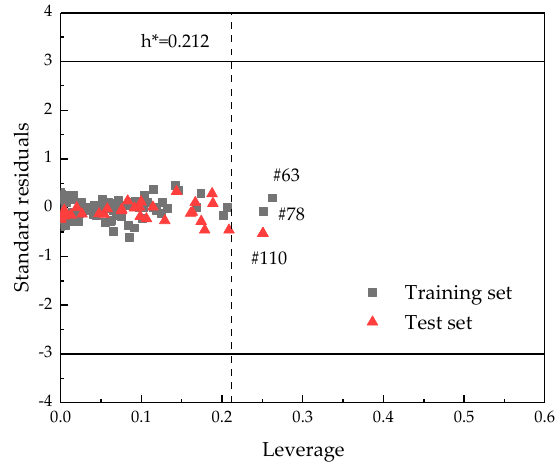
Figure 5. A Williams plot describing the applicability domain of the Quantitative Structure-Property Relationship (QSPR) model ( h * = 0.212).